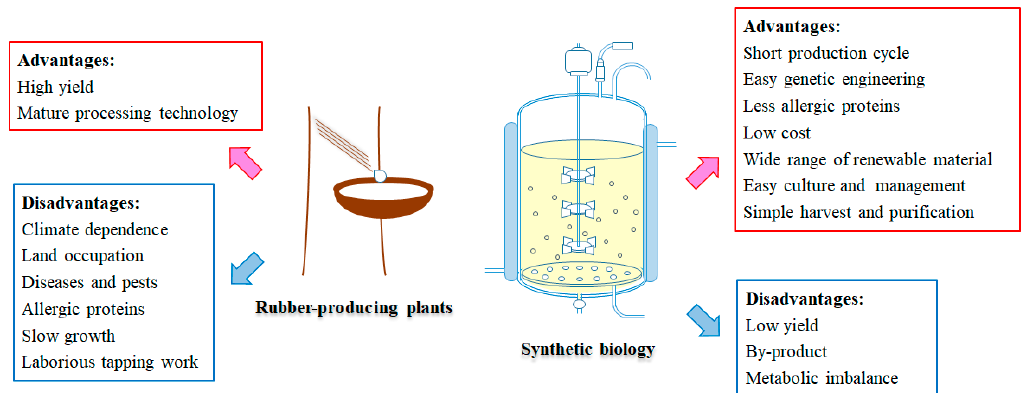
Figure 5. Comparison of rubber production from rubber-producing plants (take H. brasiliensis for example) and synthetic biology.